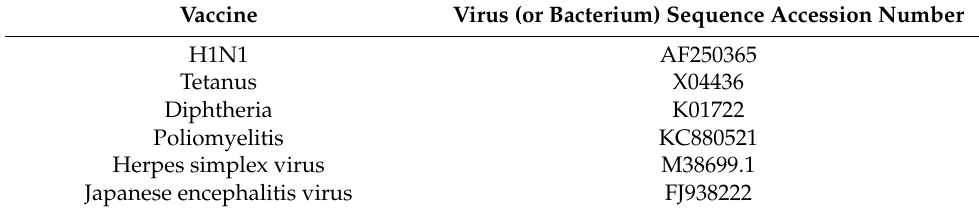
Table 2. Sequences of virus (or